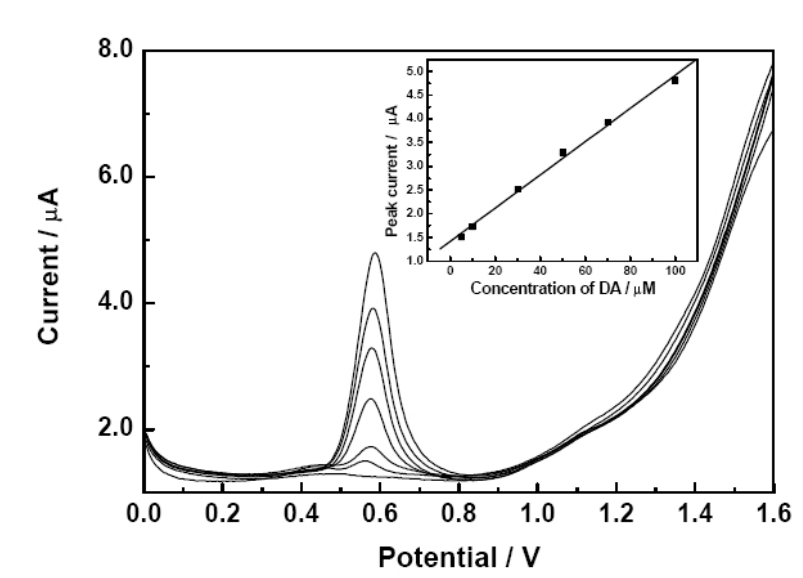
Fig. 5 DPVs of the DA in the absence of 1 × 10 − 3 M AA on BDD electrode; analytical concentration of DA , from bottom to top: 0 . 5 × 10 − 6 , 1 × 10 − 5 , 3 × 10 − 5 , 5 × 10 − 5 , 7 × 10 − 5 , 1 × 10 − 4 M. Inset figures is linear correlation between peak current and concentration of DA. (The increment E: 0.004 V; Amplitude: 0.05 V; Pulse width: 0.05 s; Pulse period: 0.2 s).